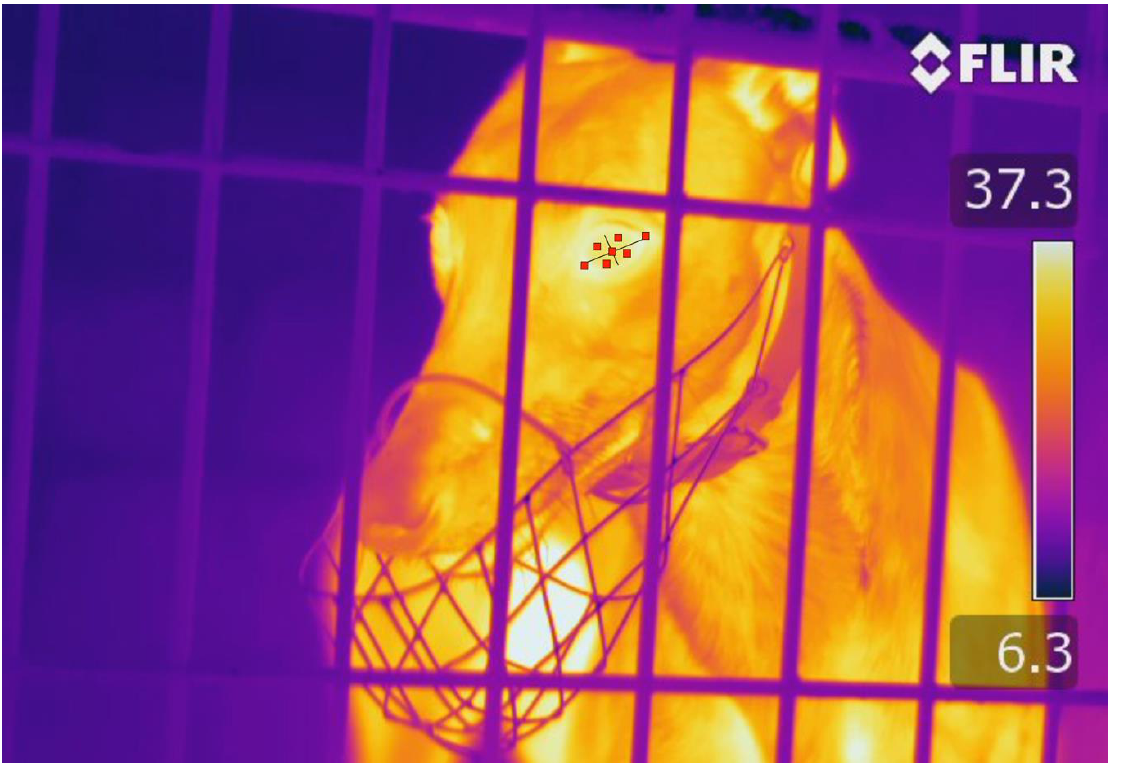
Figure 1. ( a ) The seven locations where the Region of Interest averages were recorded on the right eye. ( b ) The seven lo- cations where the Region of Interest averages were recorded on the left eye.